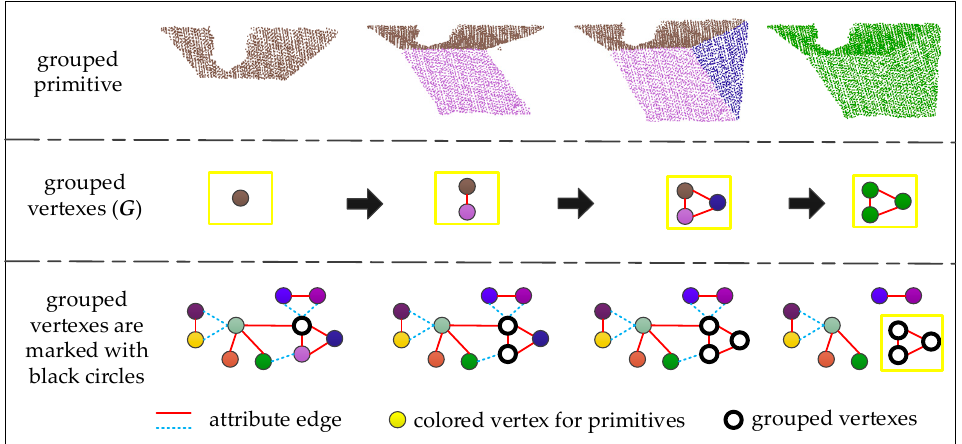
Figure 6. One iteration of the progressive grouping process. A grouped structure is a sub-graph in the RAG, marked in the illustration with a yellow rectangle and black circles.